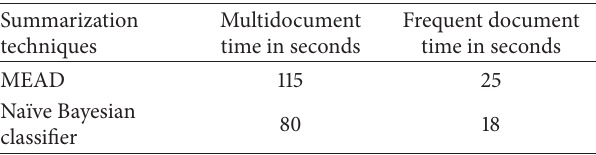
Table 3: Comparison of frequent versus multidocument summa- rization using MEAD and NA¨IVE Bayesian classifier.